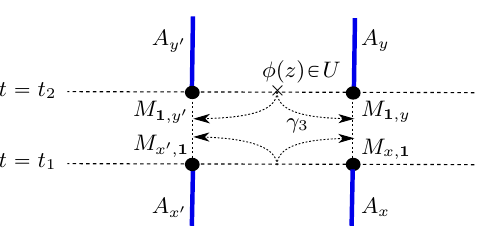
Figure 11 . This picture depicts a special situation on the 1+1D world sheet of the chiral gapless edge p V; X 7 q for x; y; x 1 ; y 1 P X 0 . It shows that the horizontal U -actions on M 1 ;y 1 ; M x; 1 ; M 1 ;y ; M x; 1 are determined by the vertical U -actions via the braidings long the fours paths,